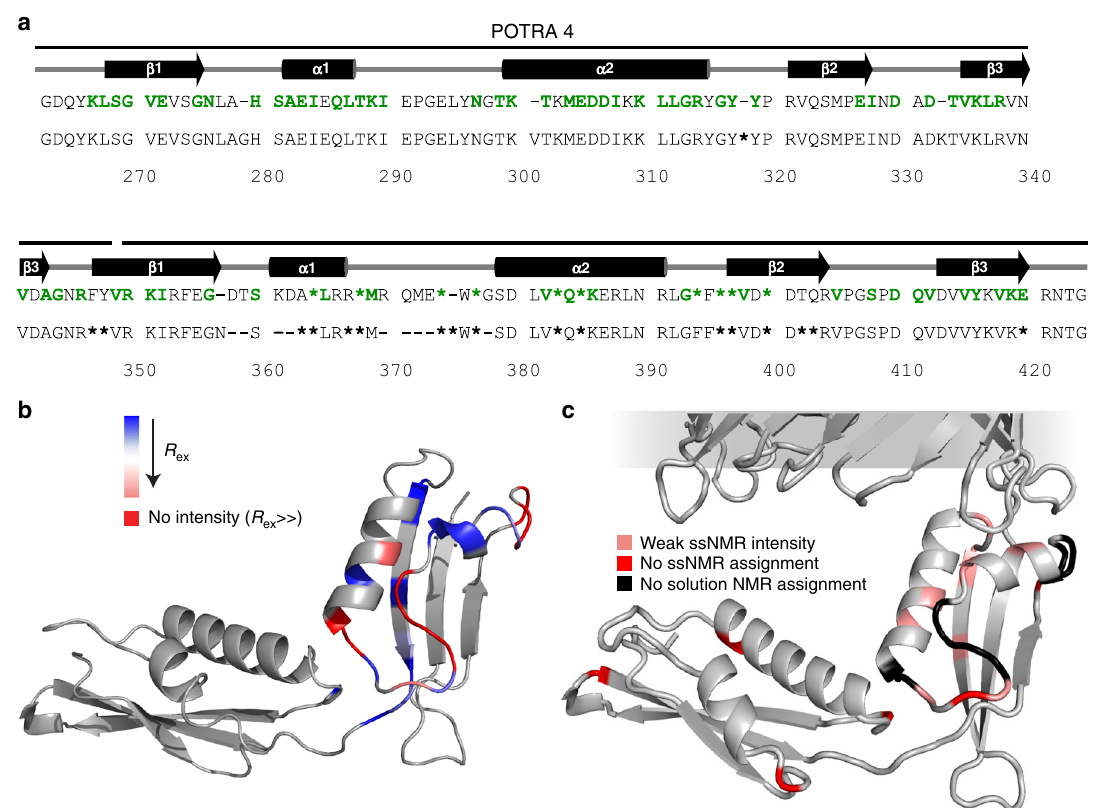
Fig. 2 P4P5 domains in liposomes compared to free solution. a Topology and secondary structural elements determined using TALOS + (BMRB 19928) depicted above the sequence for the P4P5 domains. Upper sequence: Residues identi fi ed in 1 H-detected ssNMR spectra (green and bold), those replaced with dash (-) do not appear in the spectra within 1 ppm of their solution NMR assignment. Residues replaced with asterisks (*) show weak signals. Lower sequence: Residues replaced with asterisks ( * ) show dynamics as judged by 15 N CPMG relaxation (solution NMR). Residues replaced with a dash ( - ) could not be assigned in solution. b R ex plotted on the crystal structure of P4P5 (PDB 3Q6B). Box in the top left indicates the extent of chemical exchange. Adapted from Structure, 23, Sinnige, T. et al., Conformational Plasticity of the POTRA 5 Domain in the Outer Membrane Protein Assembly Factor BamA, 1317 – 1324, copyright (2015) with permission from Elsevier 35 . c P4P5 residues that are not present at the solution NMR assignment in liposomes, in both the C α NH and the CONH ssNMR spectra (red) plotted on the crystal structure (PDB 5D0O), in light red are residues with weak ssNMR intensity and in black are those which were not assigned in